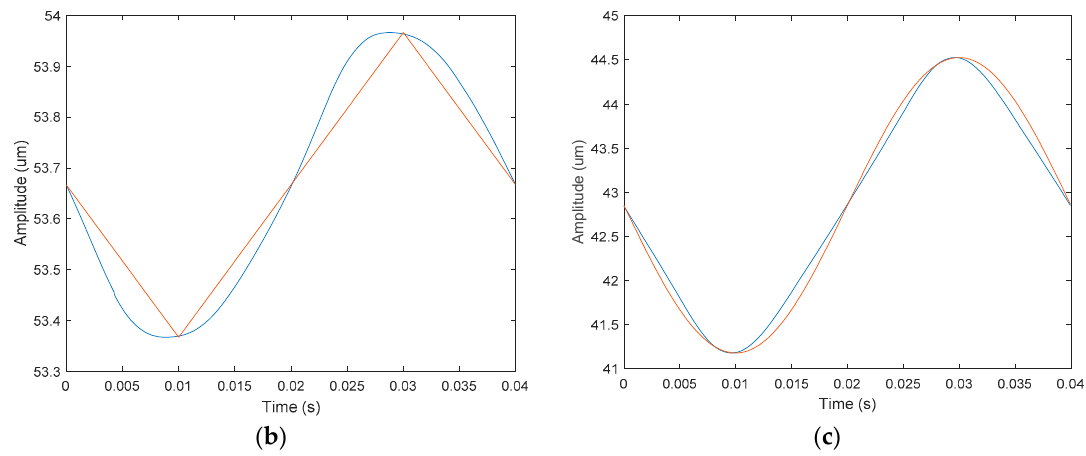
Figure 28. Response curve in y direction. ( a ) Square wave signal; ( b ) triangle wave signal; ( c ) sine wave signal.